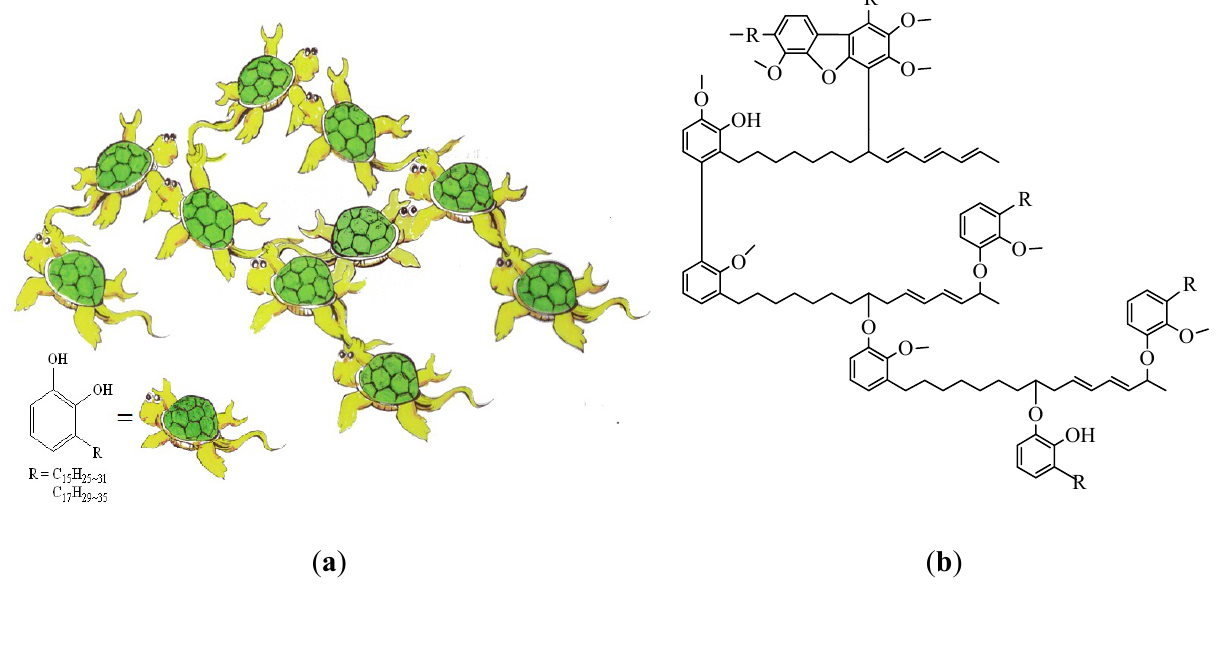
Figure 4. Image ( a ) and chemical structure ( b ) of lacquer